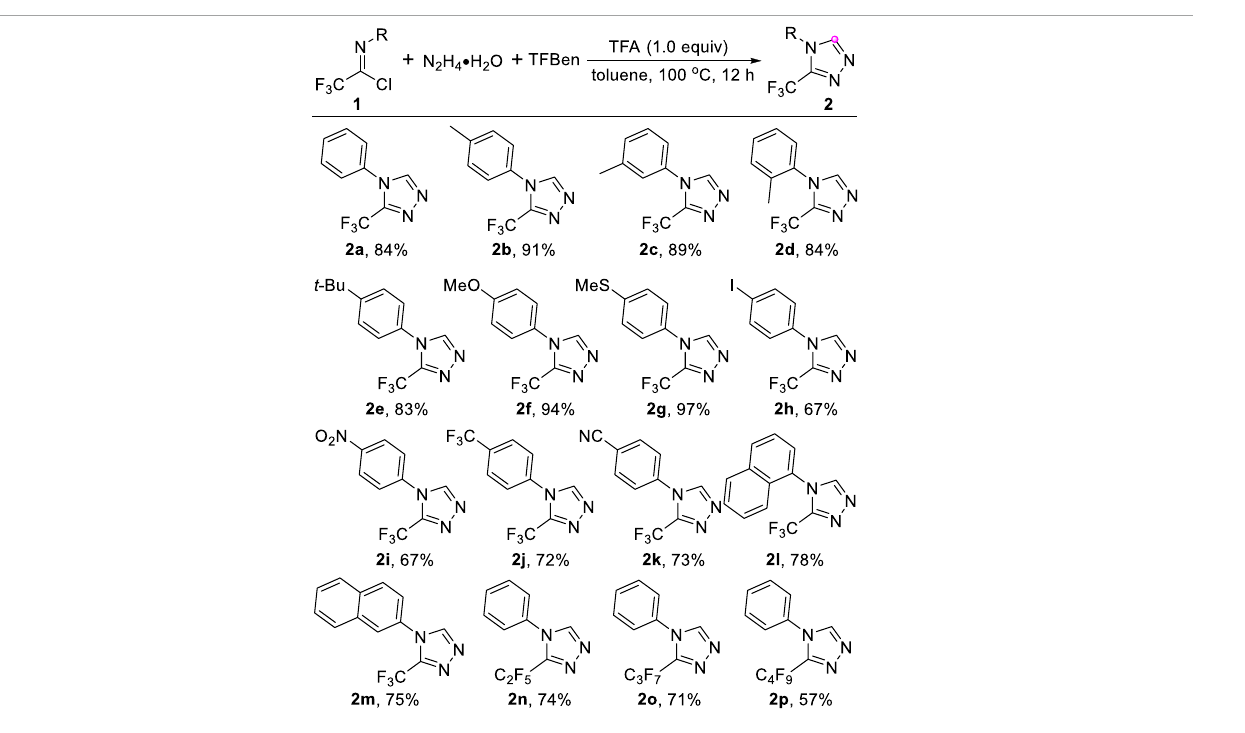
TABLE 2 Scope of tri fl uoroacetimidoyl